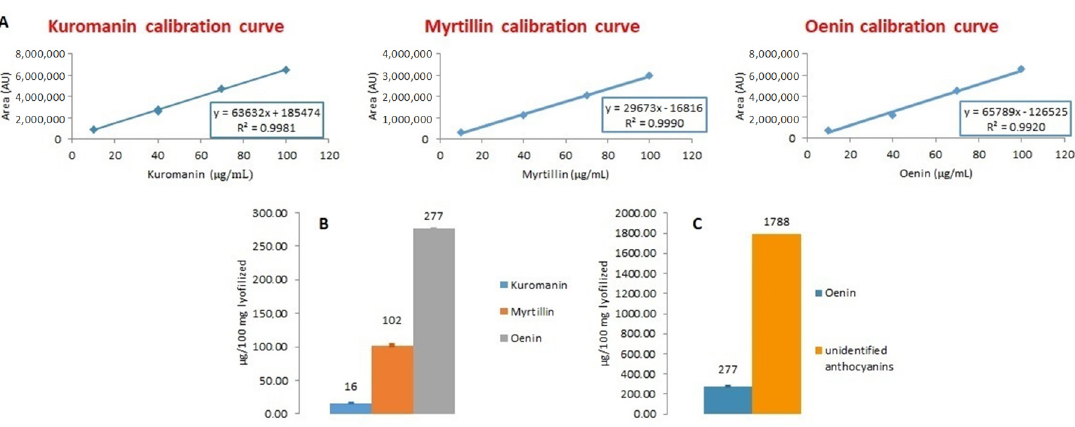
Figure 7. ( A ) Calibration curves of kuromanin, myrtillin and oenin with their corresponding regression equations and coefficients of determination; ( B ) quantification of kuromanin, myrtillin and oenin; ( C ) quantification of unidentified anthocyanins.